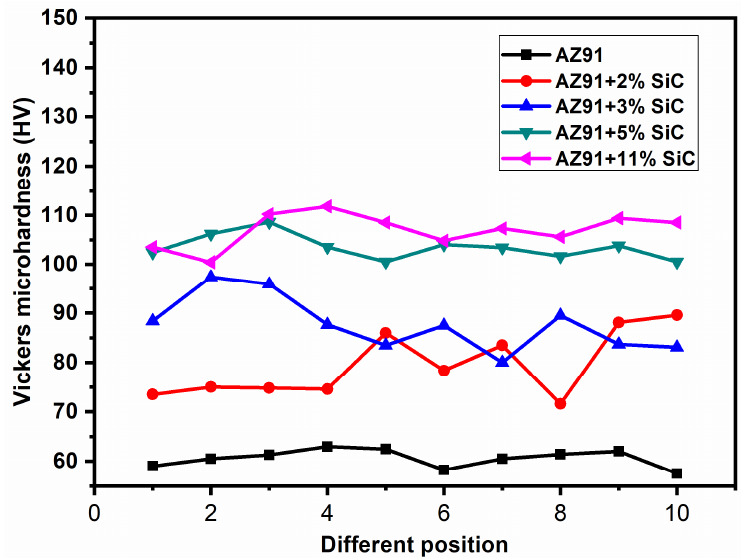
Figure 4. Microhardness data of magnesium alloy and its composites with different (2%, 3%, 8% and 11%) weight percentages at different locations. Table 3. Vickers microhardness of magnesium alloy and its composite.